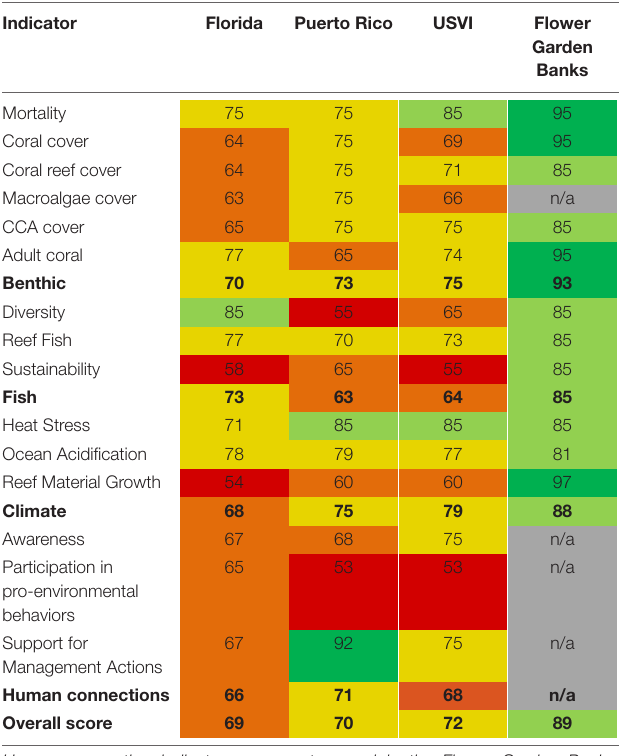
Human connection indicators were not scored in the Flower Garden Banks, which is indicated by gray boxes. Colors refer to scoring bins described in the methods section with dark green representing Very good, light green representing Good, yellow representing Fair, orange representing Impaired, and red representing